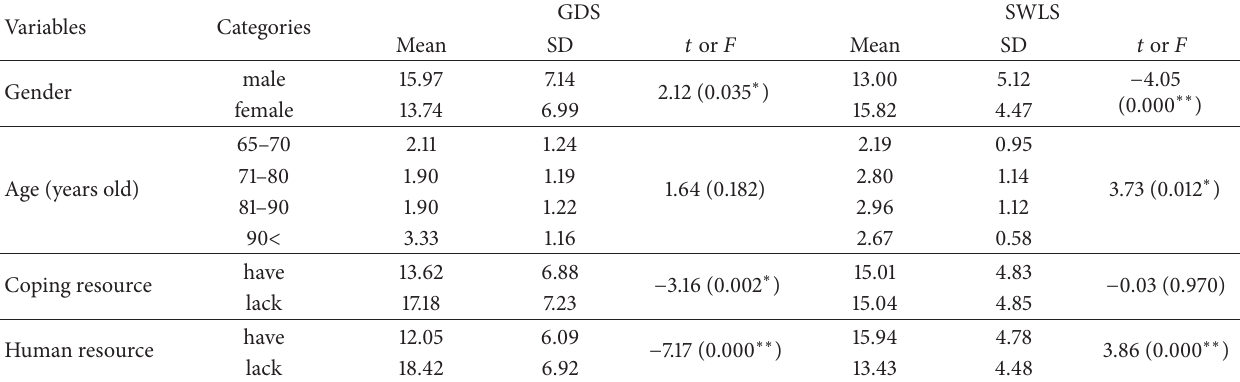
Table 2: GDS and SWLS by multiple